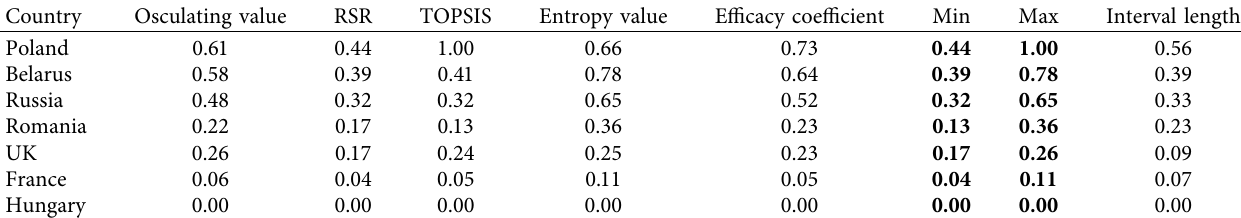
Table 13: Matching result of Chinese power companies in